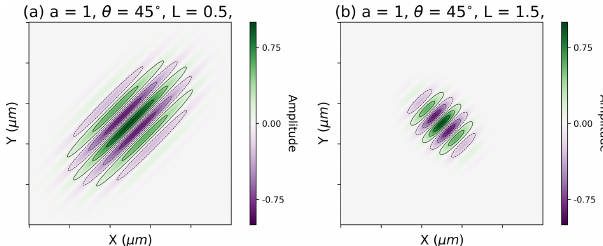
Figure A2. Examples of how a wavelet changes with the anisotropy ratio ( L